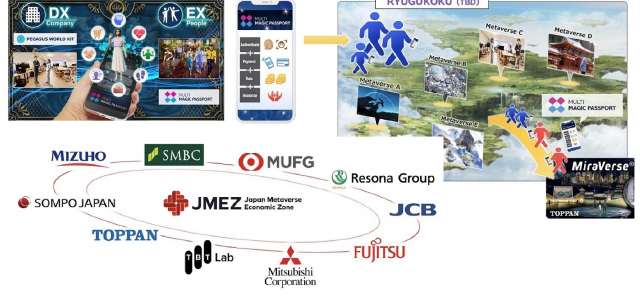
Figure 10: Metaverse Economic Zones, MEZs, Japan Dubai’s